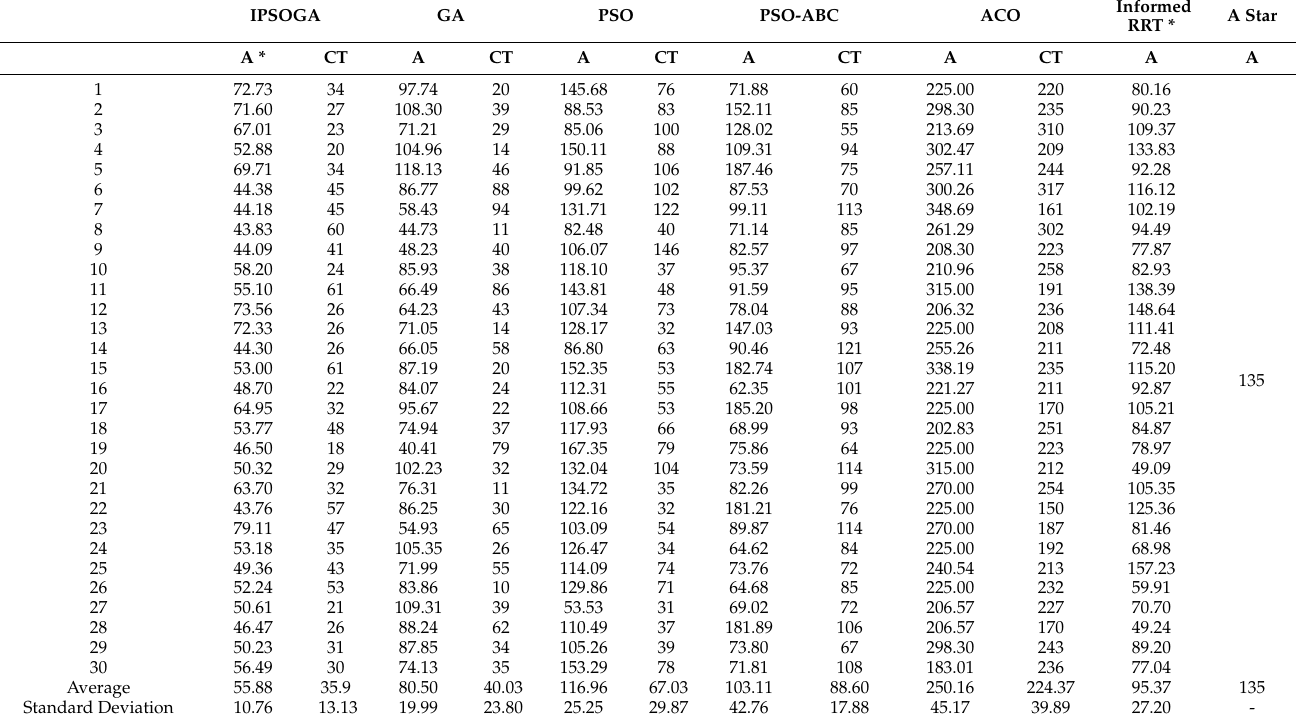
Table 4. Comparison of Algorithm Angle and Convergence Experimental Results (simple environment).